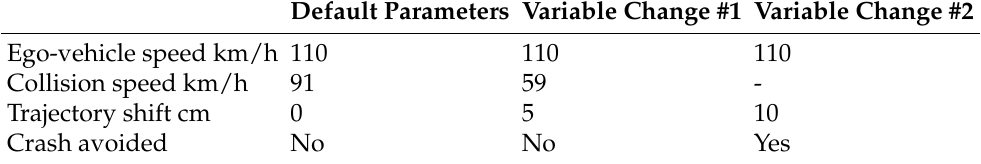
Table 4. Comparison of the effect of trajectory